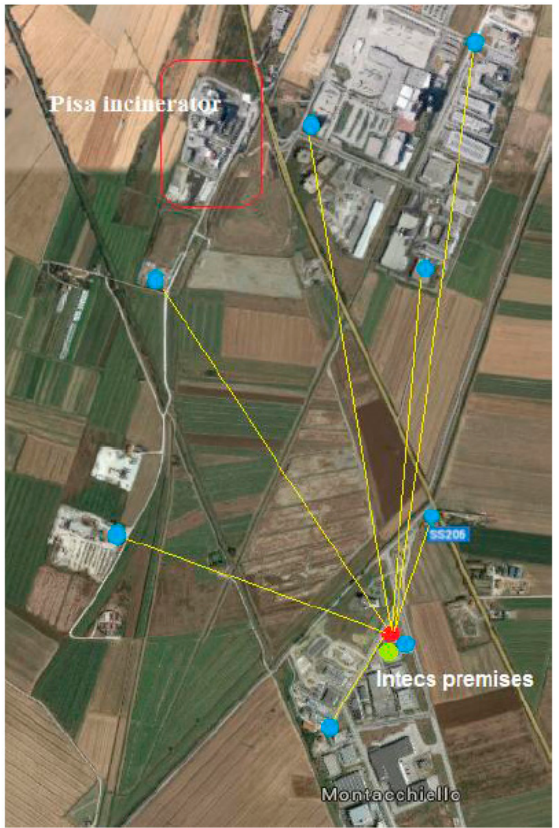
Figure 27. Application scenario for the air quality monitoring demonstrator.